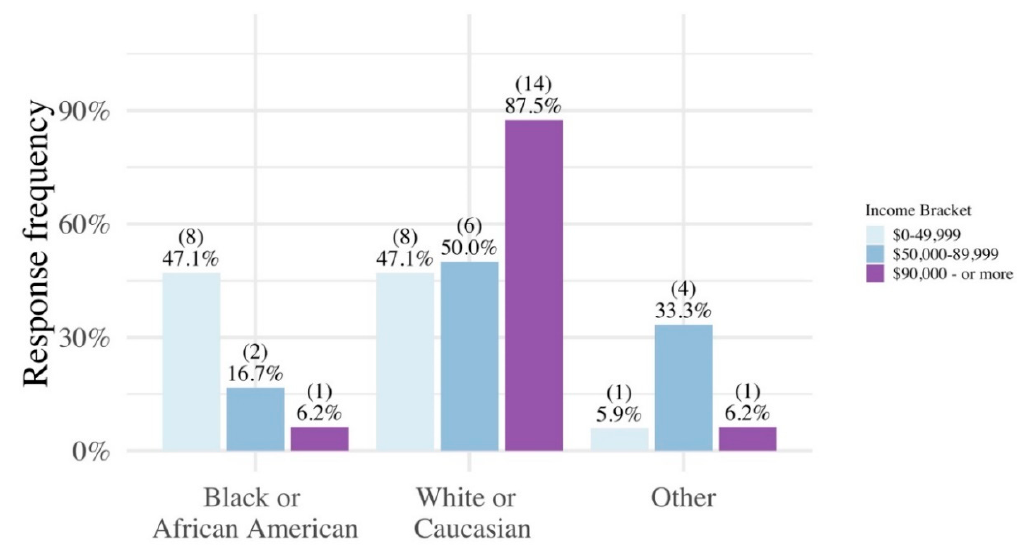
Figure A1. Income vs. Race of Participants. Total question respondents: 51.